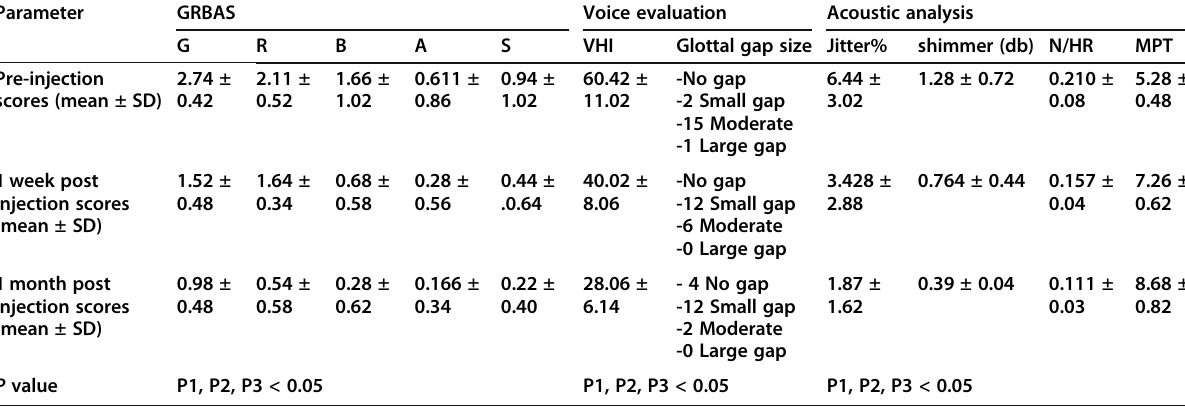
Table 2 Comparison between pre-injection and post-injection results of voice analysis after IL by local anesthesia ( n = 18) Parameter GRBAS Voice evaluation Acoustic